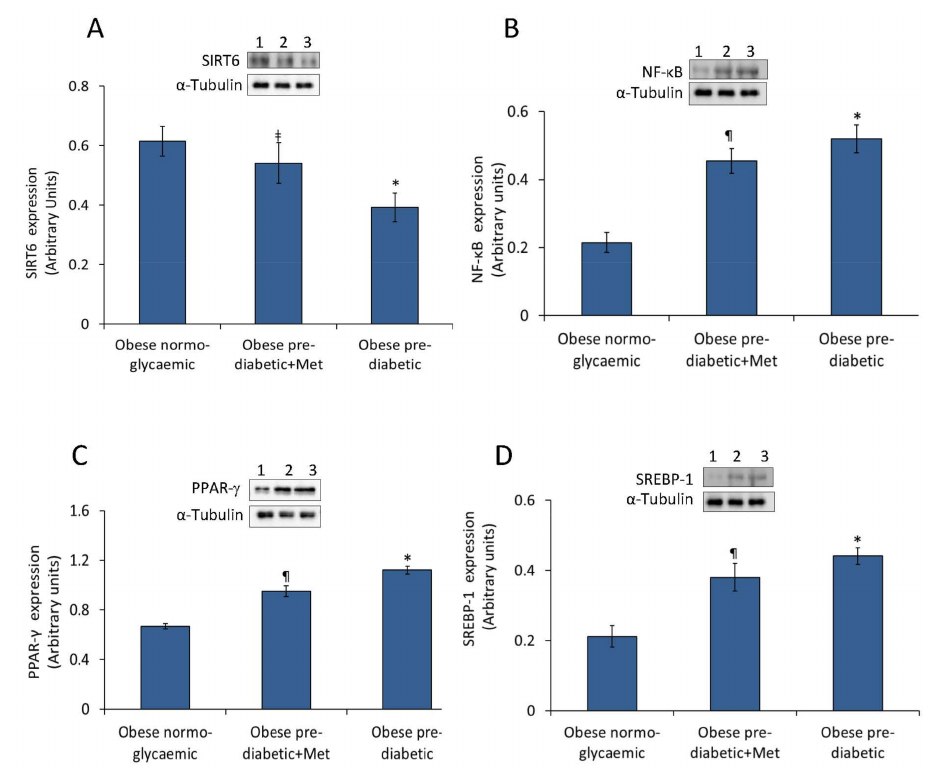
Figure 1. Protein expression levels of SIRT6, NF- κ B, PPAR- γ and SREBP-1 in abdominal adipose tissue. ( A ) SIRT6, ( B ) NF- κ B, ( C ) PPAR- γ , and ( D ) SREBP-1 protein levels determined by Western blot